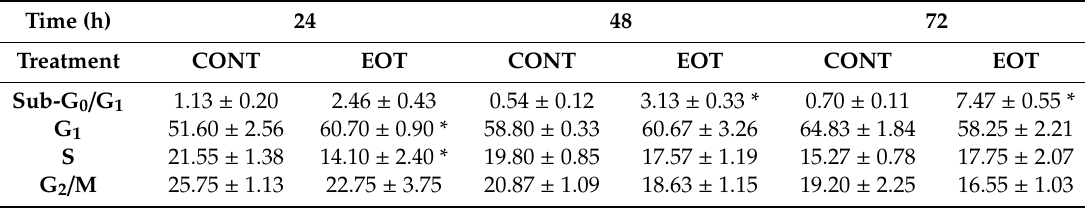
Table 4. Cell cycle distribution in MDA-MB-231 cells after EOT treatment.